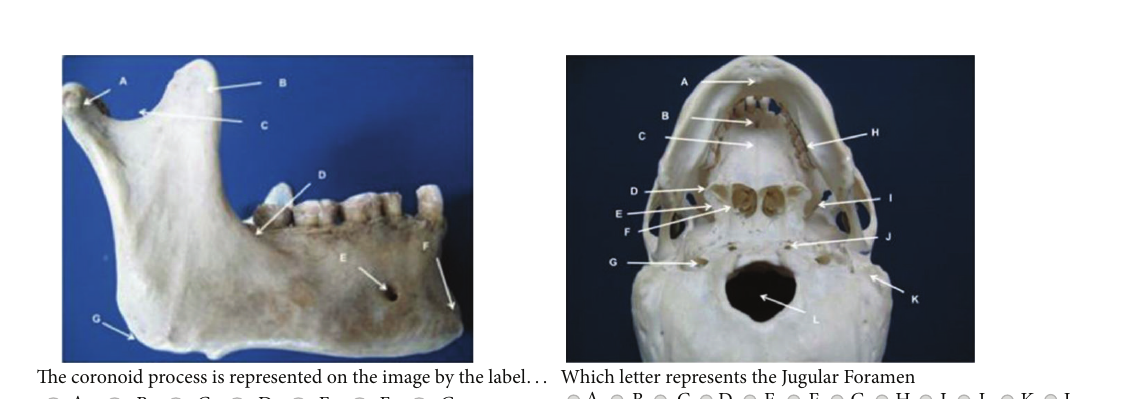
Figure 1: Two examples of the online digital library and online quiz images developed for the course reported in this